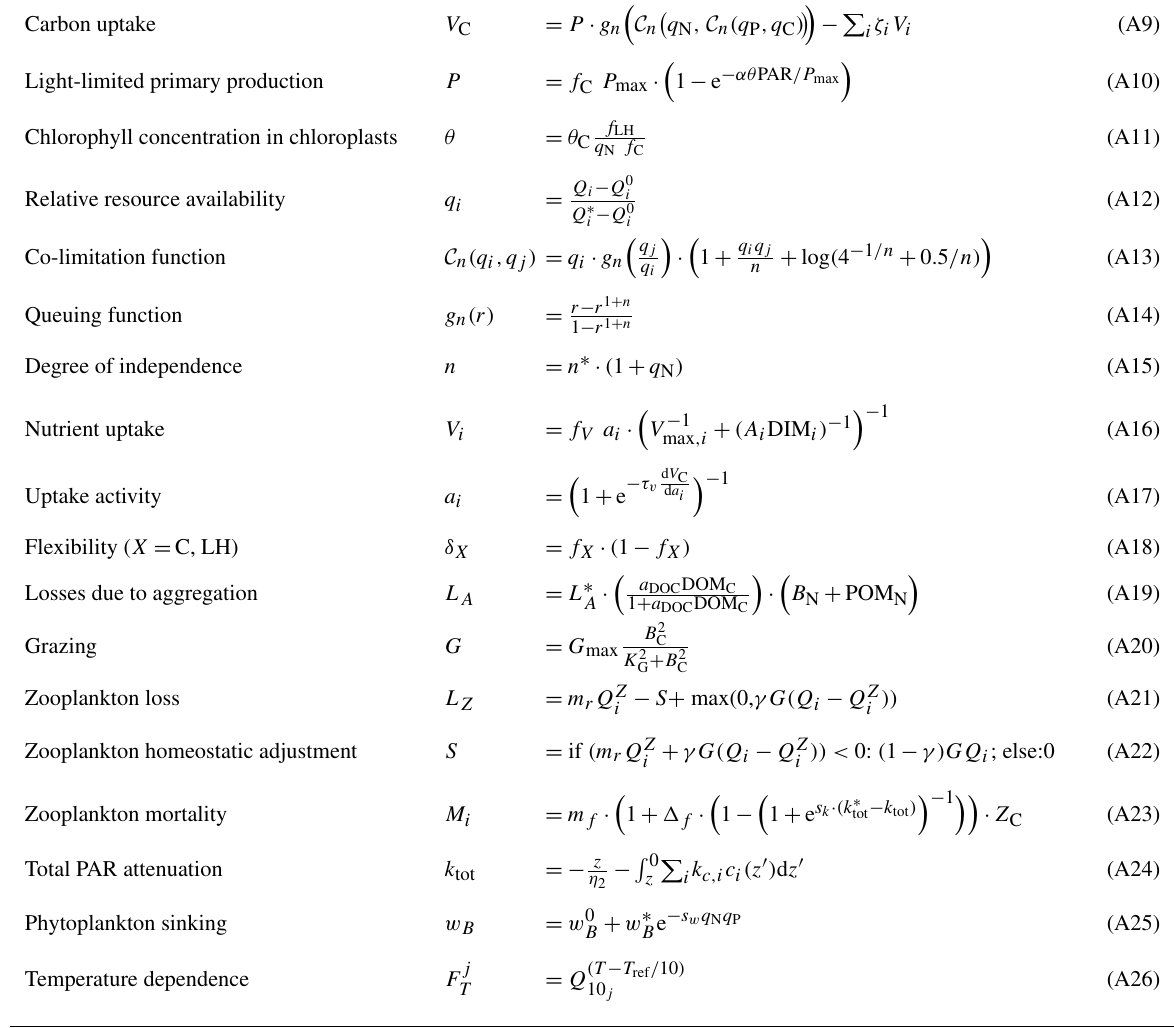
Table A2. Process descriptions and functional relationships. The index i represents the elements C, N and P. The index j represents groups with different Q 10 values. Description of parameters (lowercase letters) are provided in Table